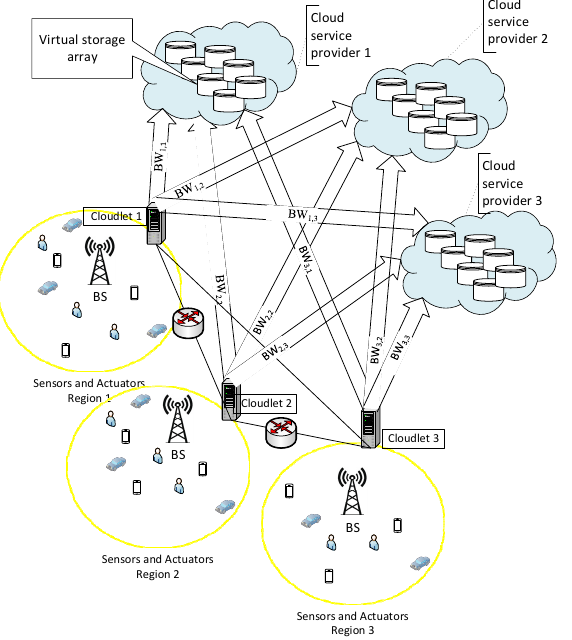
Figure 1. Proposed architecture from sensors through cloudlet to cloud providers for storing IoT data. Each cloudlet manages a batch of data to be processed in or out of that cloudlet. The proposed algorithm runs in cloudlet to find appropriate services in and out of cloudlet in both layers. The storage capacity and CPU are both considered in service allocation.